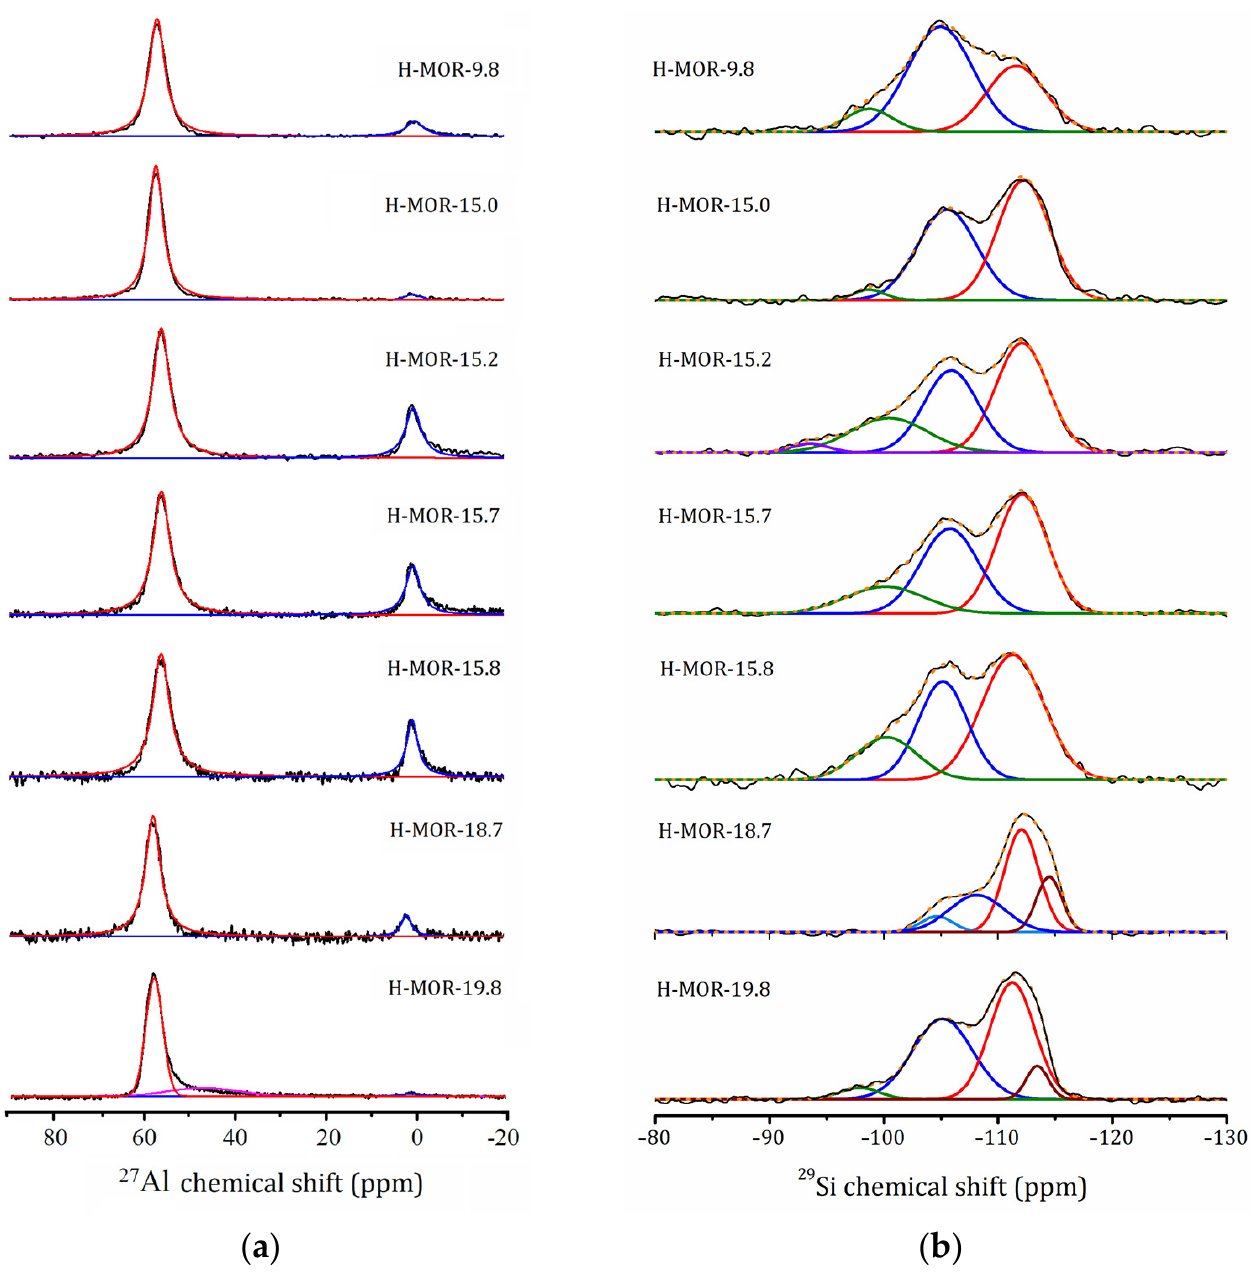
Figure 4. 27 Al ( a ) and 29 Si ( b ) MAS NMR spectra of the studied samples and their decomposition.